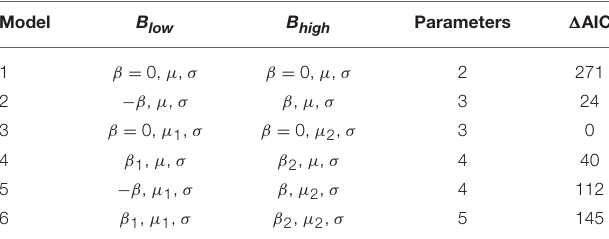
FIGURE 6 | Examples of pairs of functions with (A) equal and opposite biases ( β ) and (B) equal and opposite shifts in the mean ( µ ). For these example functions µ 0 and σ 1. The values for the shifts of µ were = = chosen to produce a similar PSEs to the bias values. TABLE 1 | Description of models and AIC differences ( 1